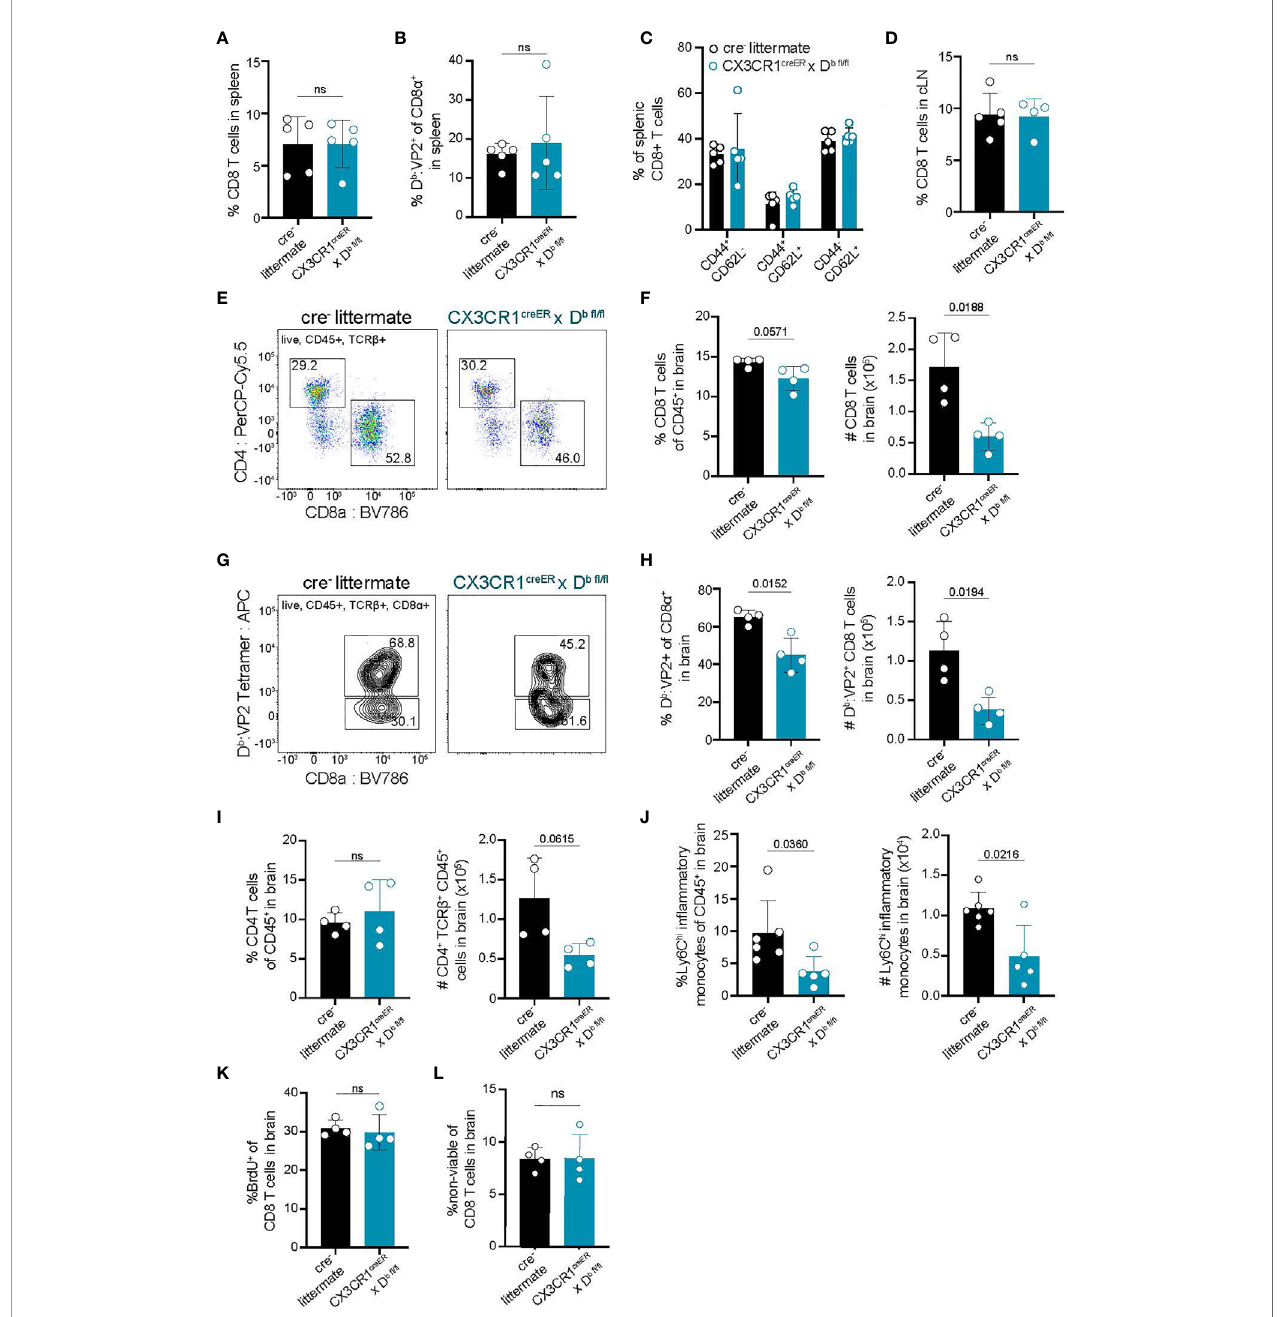
FIGURE 5 | Deletion of H-2D b in CNS-myeloid cells reduces neuroin fl ammatory responses to the D b restricted viral antigen VP2 121-130 during TMEV infection of the CNS. Experimental strategy is identical to Figure 3E , in which tamoxifen administration in CX3CR1 cre /D b mice and cre - controls is followed by a 6-week reconstitution period before i.c. infection with TMEV. Spleens, lymph nodes, and brains were analyzed by fl ow cytometry at 7 days post infection to assess antiviral responses. (A, B) Quanti fi cation of CD8 + T cells (A) and D b : VP2 + CD8 T cells (B) in the spleens of infected mice. (C) Proportion of naïve (CD44 - CD62L + ), effector (CD44 + CD62L - ), and central memory (CD44 + CD62L + ) CD8 T cells in the spleens of infected mice. (D) Quanti fi cation of CD8 + T cells in the dCLN of infected animals. (E) Representative fl ow cytometry plots, and (F) quanti fi cation of CD8 T cells in fi ltrating the brain at 7 dpi in CX3CR1 cre /D b mice compared to controls. (G) Representative fl ow cytometry plots, and (H) quanti fi cation of total D b : VP2 + CD8 T cells in fi ltrating the brain at 7 dpi. (I) Quanti fi cation of CD4 T cells recovered from the brains of mice during infection. (J) In fl ammatory monocytes recovered from the brains of infected mice are quanti fi ed. (K) BrdU was administered intraperitoneally at day 6 post infection and BrdU incorporation into brain-in fi ltrating CD8 T cells was quanti fi ed. (L) Viability dye incorporation was measured in CD8 T cells isolated from the brains of infected mice. Data are shown as individual mice with mean from one independent experiment (n=3-6) of ≥ 3 experimental replicates. Error bars represent standard deviation. Two tailed Welch ’ s t test was used to assess statistical signi fi cance with ns p ≥